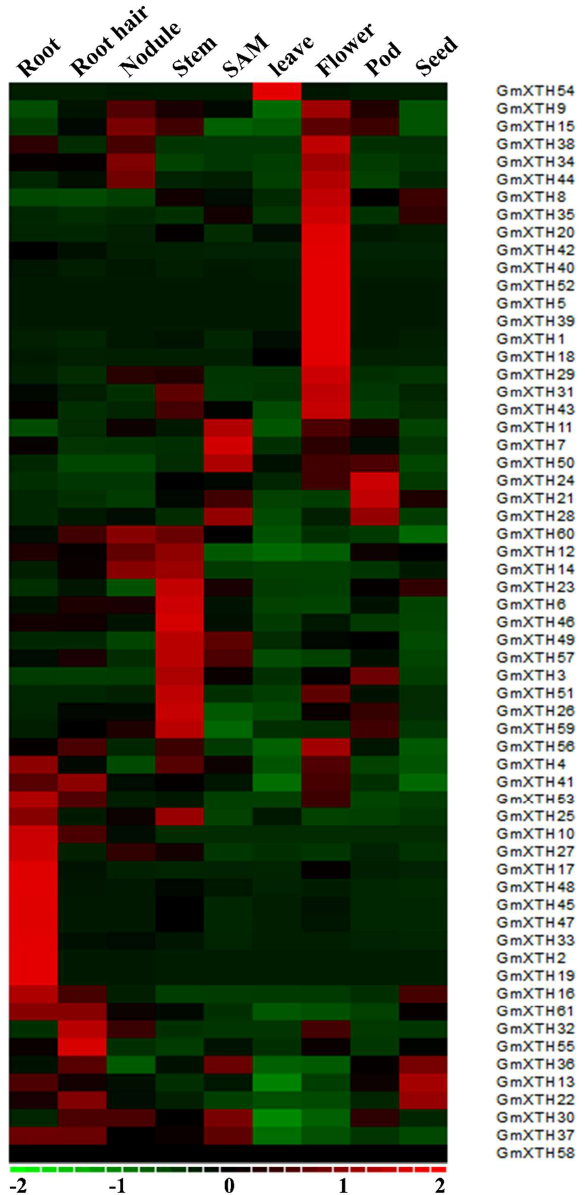
Figure 4. Heatmap of the expression profiles of the GmXTH gene family in nine organs. Relative organ expression levels of GmXTHs based on RNA-seq data were used to construct the heatmap. The expression values (Reads Per Kilobase Million) were median-cantered and normalized for each gene in different tissues before transforming to color scale. The color bar at the bottom shows the range of expression values from highest expression level (red) to lowest expression level (green), and 0 is the median expression level (Black). SAM (Shoot Apical Meristem)